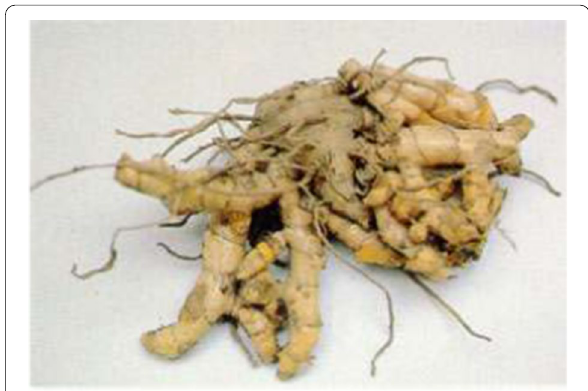
Fig. 2 Fresh rhizomes of Curcuma longa